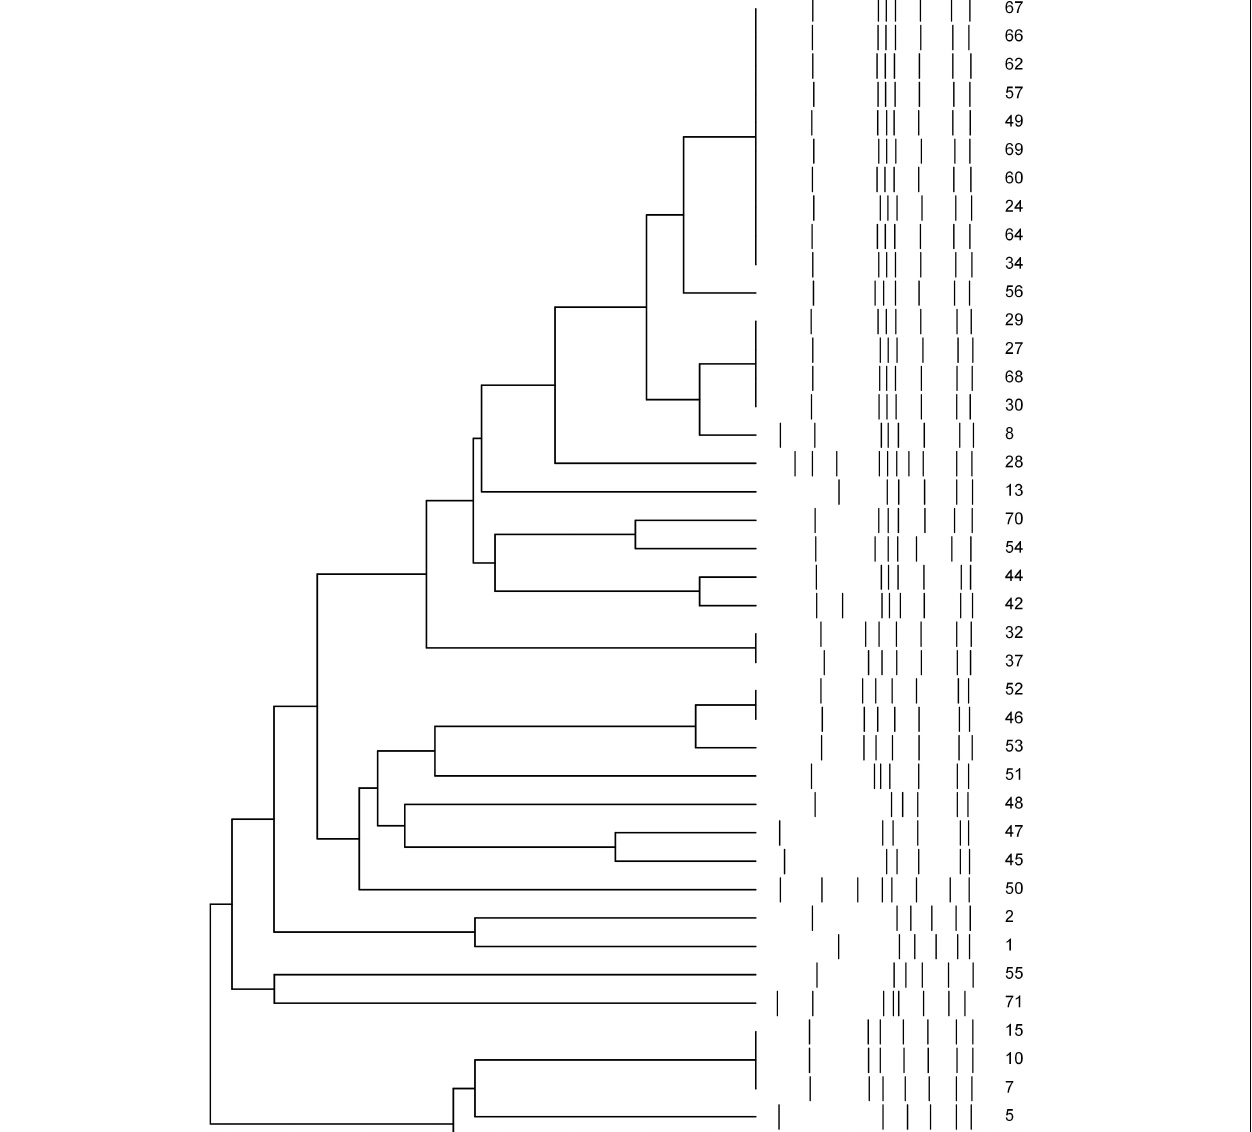
origin in Asia and elsewhere. The STs for C. coli from this study all belong to CC-1150 along with other STs obtained from the database ( Figure 4